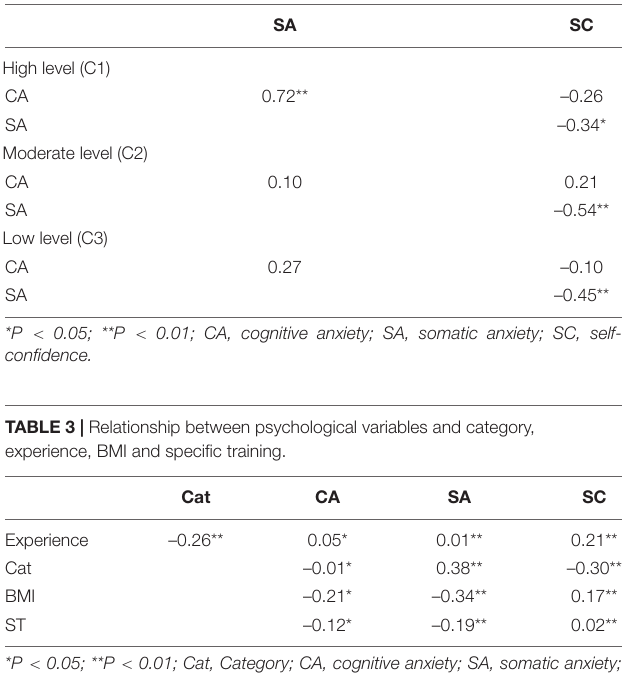
TABLE 2 | Correlation coefficient between psychological variables.